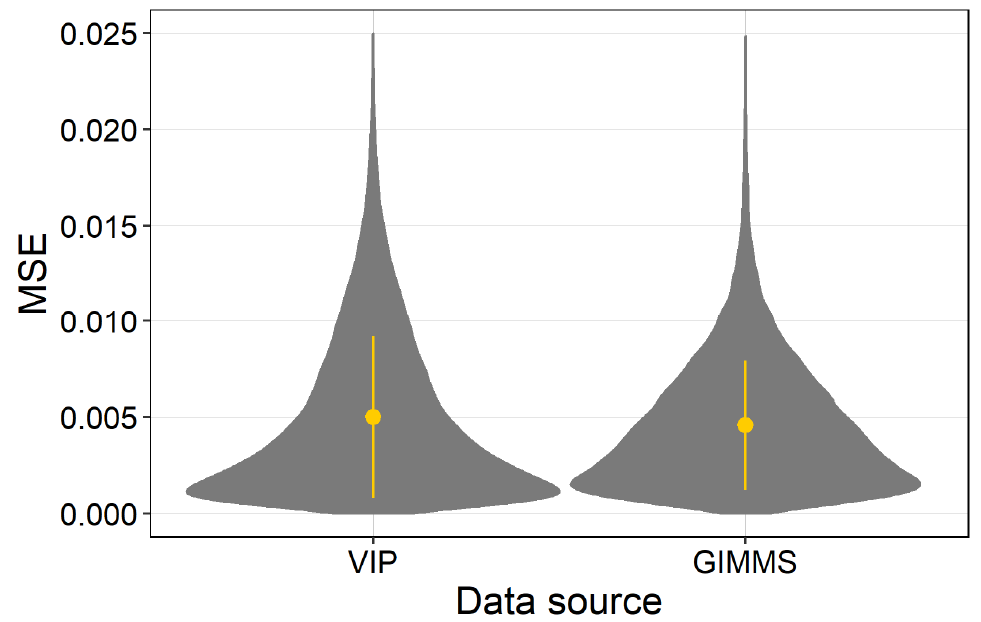
Figure 7. Comparison of the average residual sum of squares (MSE) of the fitted NDVI time series between VIP and GIMMS.